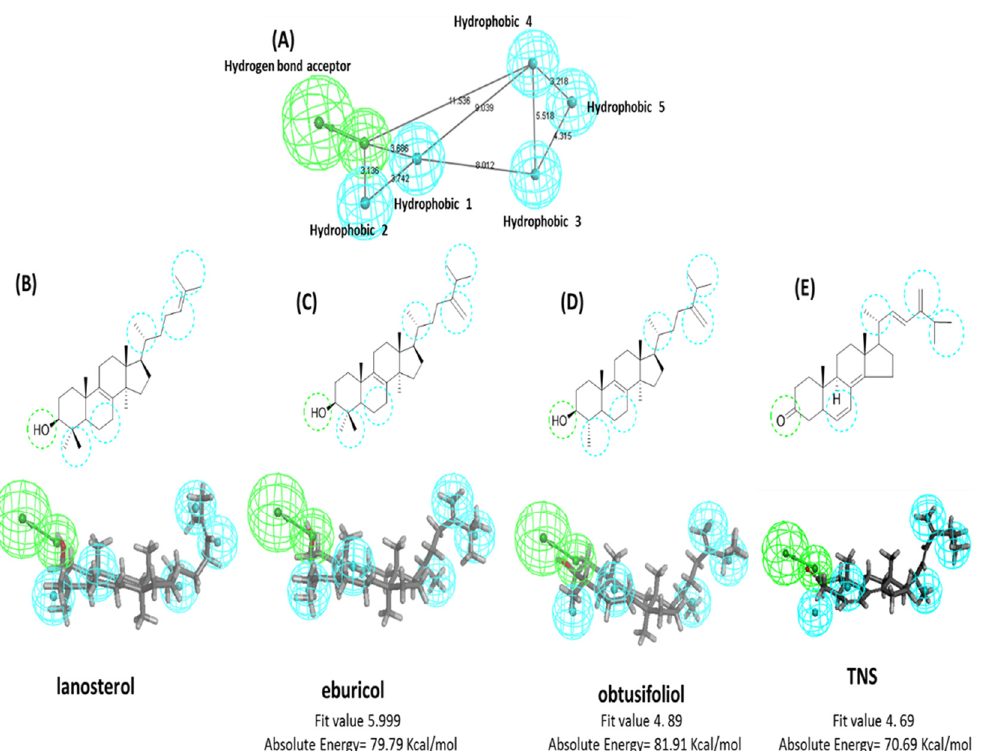
Figure 3. Common features pharmacophore of 14- α -demethylase enzyme substrates and TNS. ( A ) 3D pharmacophore generated from 14- α -demethylase enzyme substrates lanosterol, eburicol, and obtusifoliol. Cyano spheres represent hydrophobic features. Green spheres represent hydrogen bond acceptor features. Lines represent distance in Angstrom. ( B ) 2D and 3D diagram showing lanosterol alignment and feature mapping to generate a pharmacophore. ( C ) 2D and 3D diagram showing eburicol alignment and feature mapping to generate a pharmacophore. ( D ) 2D and 3D diagram showing obtusifoliol alignment and feature mapping to generate a pharmacophore. ( E ) 2D and 3D diagram showing TNS alignment and feature mapping to generate a pharmacophore.